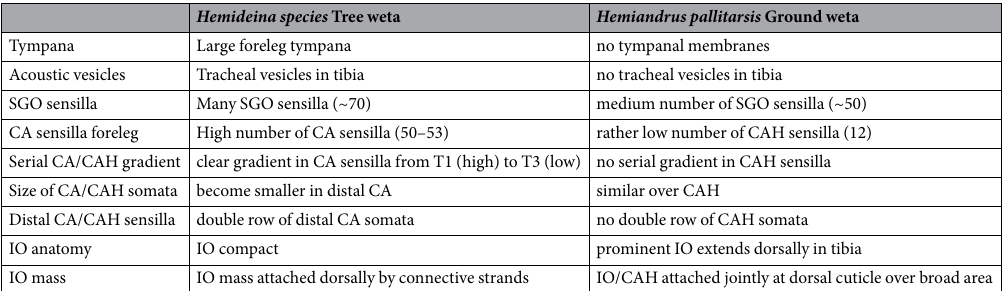
Table 2. Functional morphology of the complex tibial organ in tympanate tree weta ( Hemideina ) and atympanate ground weta ( Hemiandrus ).